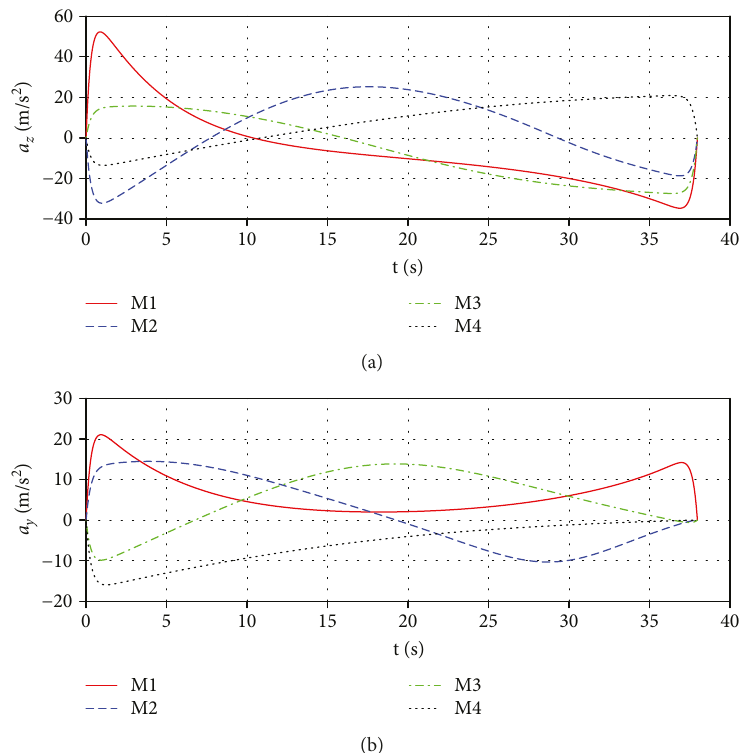
Figure 14: Missile acceleration with impact time and angle